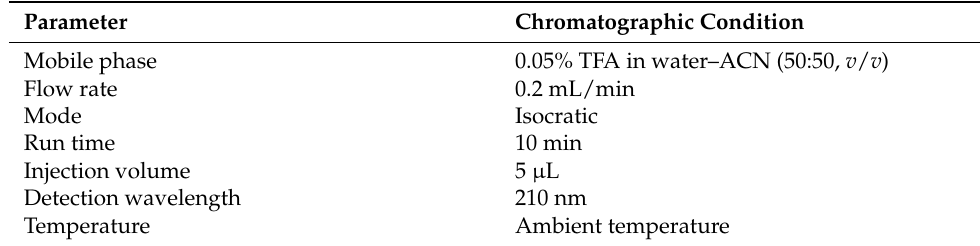
Table 1. Optimized chromatographic